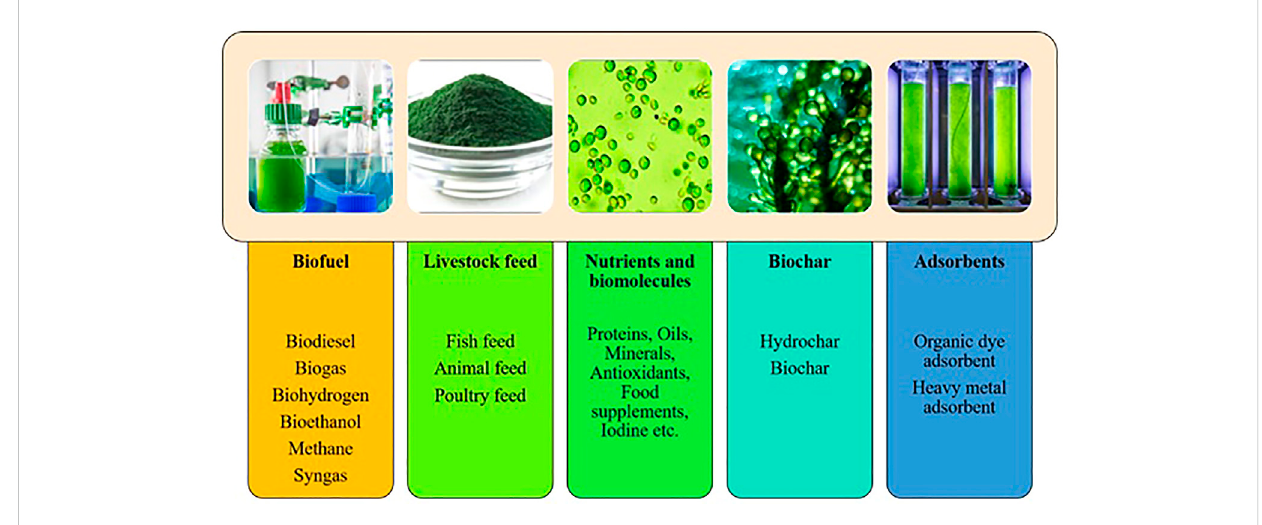
FIGURE 3 Wastewater valorisation and production of value-added products using microalgae cultivation.